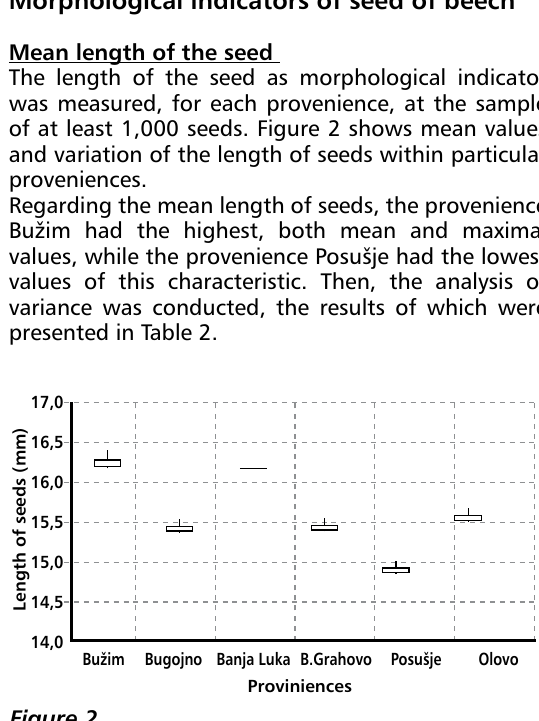
Figure 2 Mean length of seeds (mm) per proveniences By the analysis of variance, statistically significant differences have been identified at the probability of 95 % with small coefficient of variability for the researched indicator within proveniences.